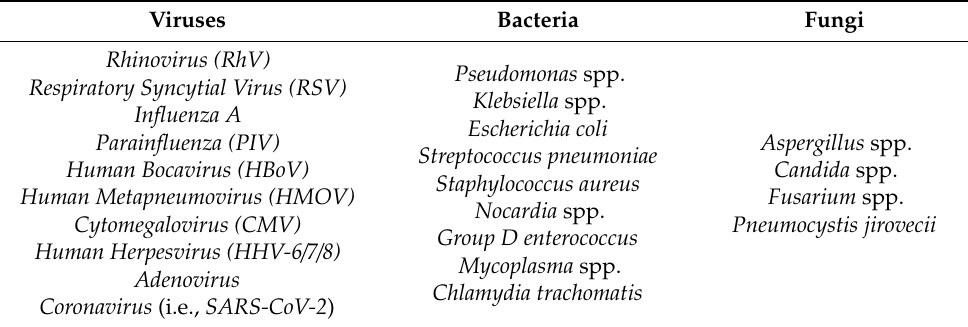
Table 1. Commonly identified respiratory pathogens in children with chemotherapy-induced